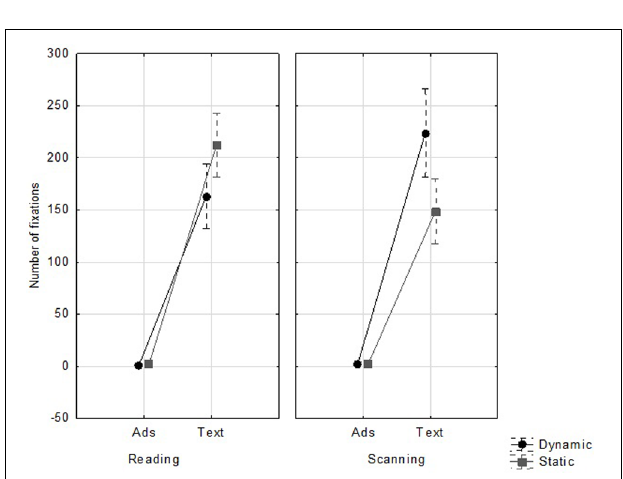
FIGURE 5 | Average number of fixations (ms) according to task, animation and zone